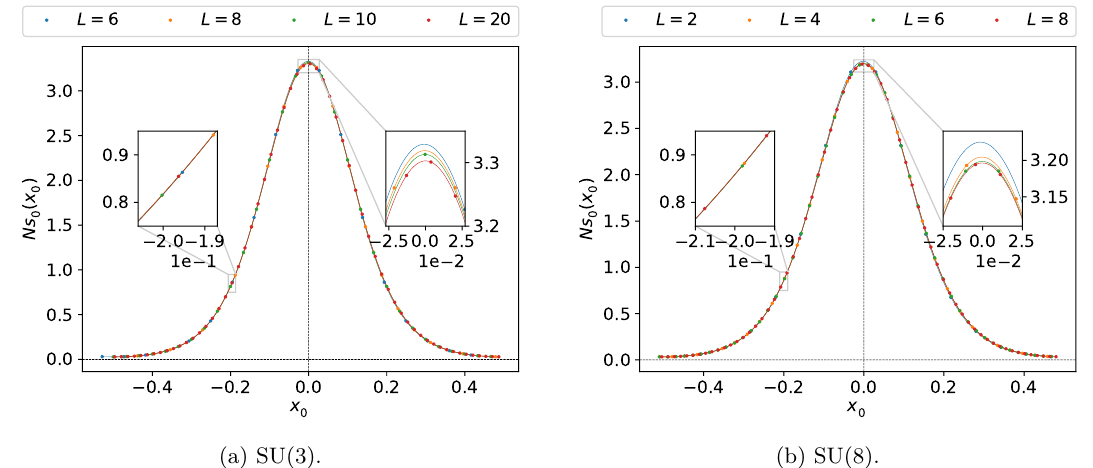
Figure 5. Continuum extrapolation of the one dimensional energy-profiles, cf. eq. (4.2) for gauge groups SU(3) and SU(8) . The torus has been discretized on a lattice with l l 1 = l 2 = La with a the lattice spacing. The continuum limit is taken by sending a = l/NL to zero at fixed value of l = 1 , i.e. by sending L to